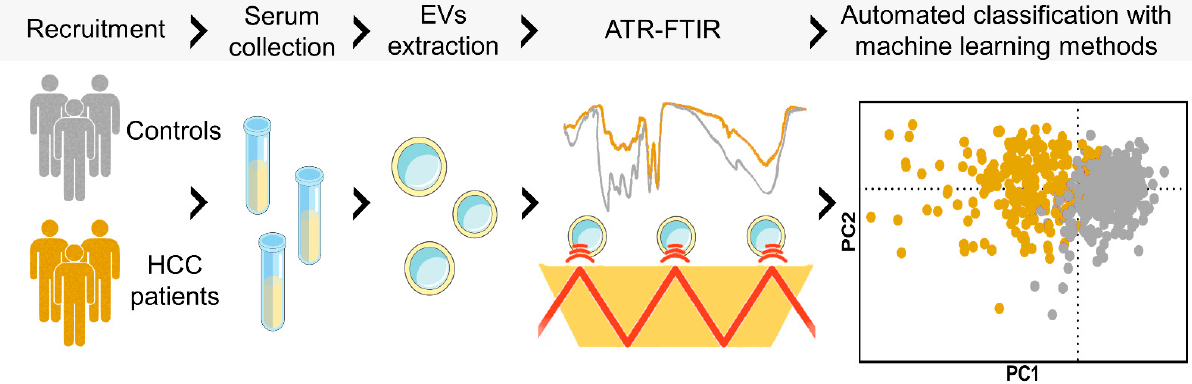
Figure 1. Schematic workflow of the presented EV-based liquid biopsy. Briefly, serum samples from HCC patients and controls were collected. EVs were isolated from serum samples and ATR-FTIR measurements were performed. Finally, automated classification of the two groups was achieved by machine learning analysis of the acquired spectra.